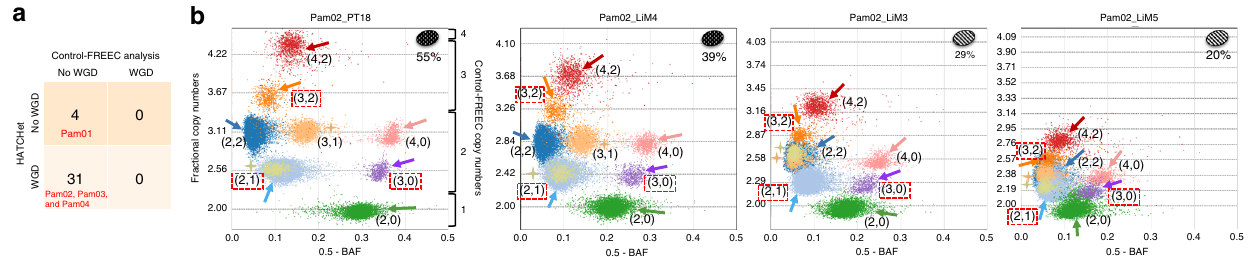
Fig. 5 HATCHet identi fi es WGDs in three of four pancreas cancer patients. a HATCHet predicts a WGD in all 31 samples from three patients (Pam02, Pam03, and Pam04). In contrast, published analysis used Control-FREEC and excluded WGDs. b In four samples of patient Pam02, HATCHet predicts a WGD and infers two tumor clones (ellipses in upper right of plot with corresponding proportions) with seven large tumor-clonal clusters (arrows with corresponding copy-number states). These clusters preserve their relative positions in the scaled BAF-RDR plot (each point corresponds to 50kb genomic bin) across samples and their fractional copy numbers correspond to sample-clonal clusters in each sample (dashed black lines), supporting the inference of a tumor-clonal CNA (i.e,. unique copy-number state across samples) for each of these clusters. Note that without a WGD three clusters (red dashed squares) would correspond to subclonal CNAs in all samples. Two additional clusters (peach and olive, starred) are tumor-subclonal as they change their relative position across samples (Pam02_PT18 and Pam02_LiM4 vs. Pam02_LiM3 and Pam02_LiM5), supporting the inference of two distinct tumor clones in this patient. The total copy numbers inferred by Control-FREEC in published analysis are shown on the right y -axis labels in the fi rst scaled